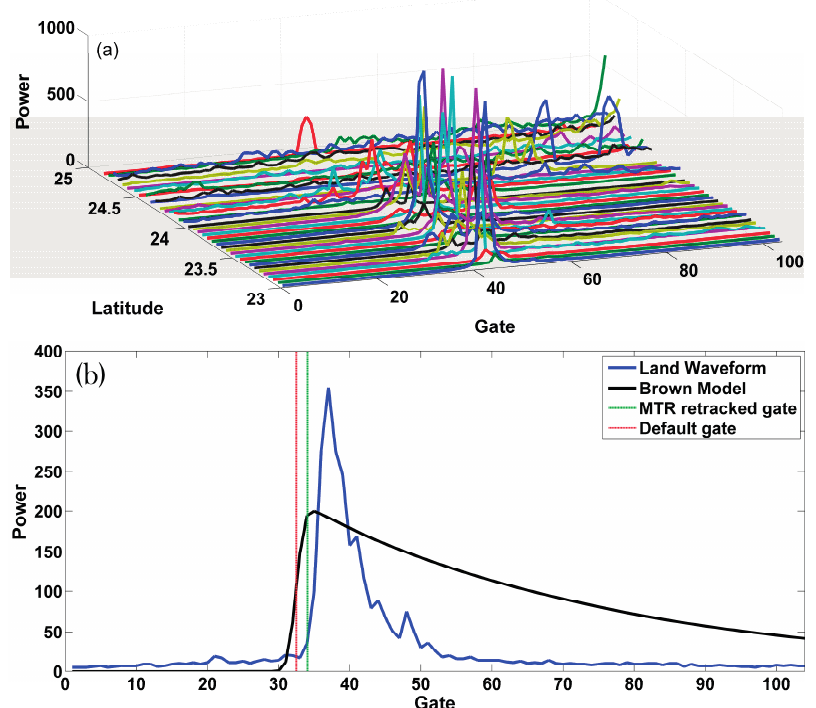
Figure 2. ( a ) J-2 along-track waveforms on land; ( b ) The MTR retracked gate (green dashed line) and the default gate (red dashed line) of the leading edge in J-2 land waveform. The blue and black curves are land waveform and Brown model,